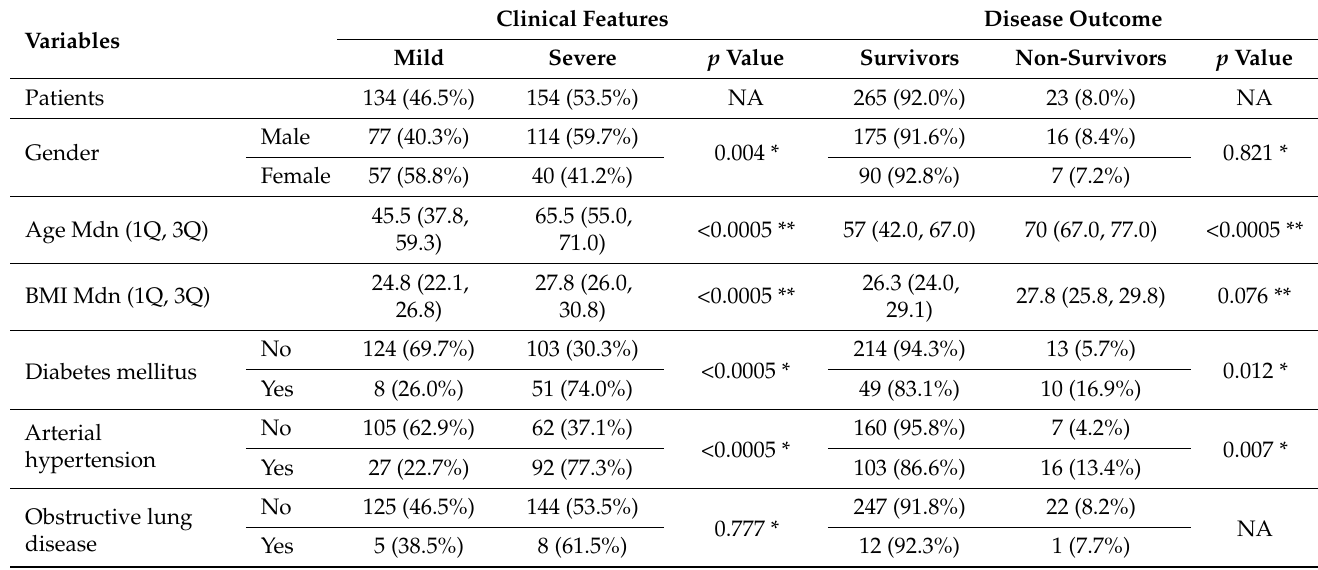
Table 1. Clinical and demographic characteristics of patients with COVID-19. The serum values of the examined biochemical parameters were obtained from blood samples immediately after admission to the hospital for treatment, while other data were obtained from the medical history (n = 288).